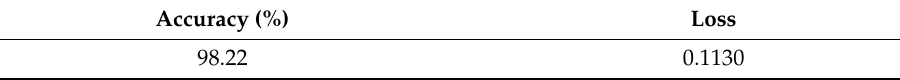
Table 6. Vehicle type classification test set results.